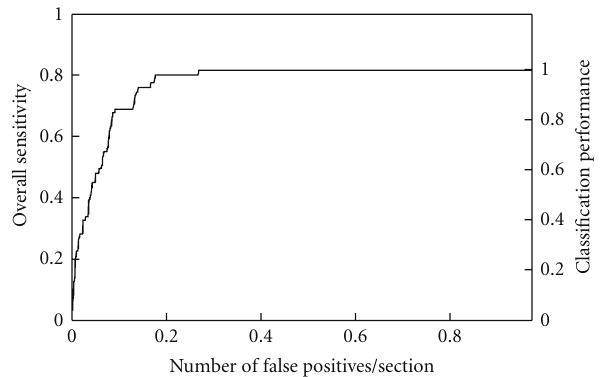
Figure 13: FROC curve indicating the performance of the MTANN in distinction between 57 true positives (nodules) and 1.726 FPs